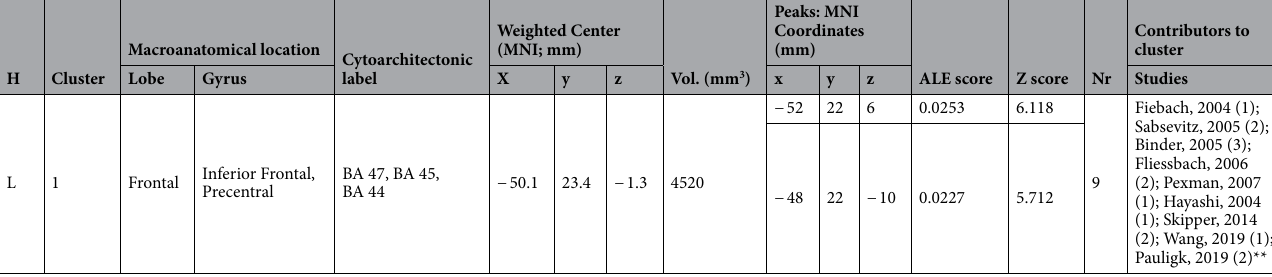
Table 7. Abstract > concrete nouns clusters. Included 99 stereotactic activation loci from 18 studies, 324 participants, chosen min. cluster size 728 mm 3 . All the values and labels were extracted from the GingerALE output files. Clusters are ordered for decreasing volume size. Coordinates (x, y, z) are in the MNI space. H = Hemisphere; ALE = activation likelihood estimation; Nr. = number of studies that contributed to each cluster; L = left; BA = Brodmann area; ** = between brackets are the number of foci from each study that contributed to that specific cluster.